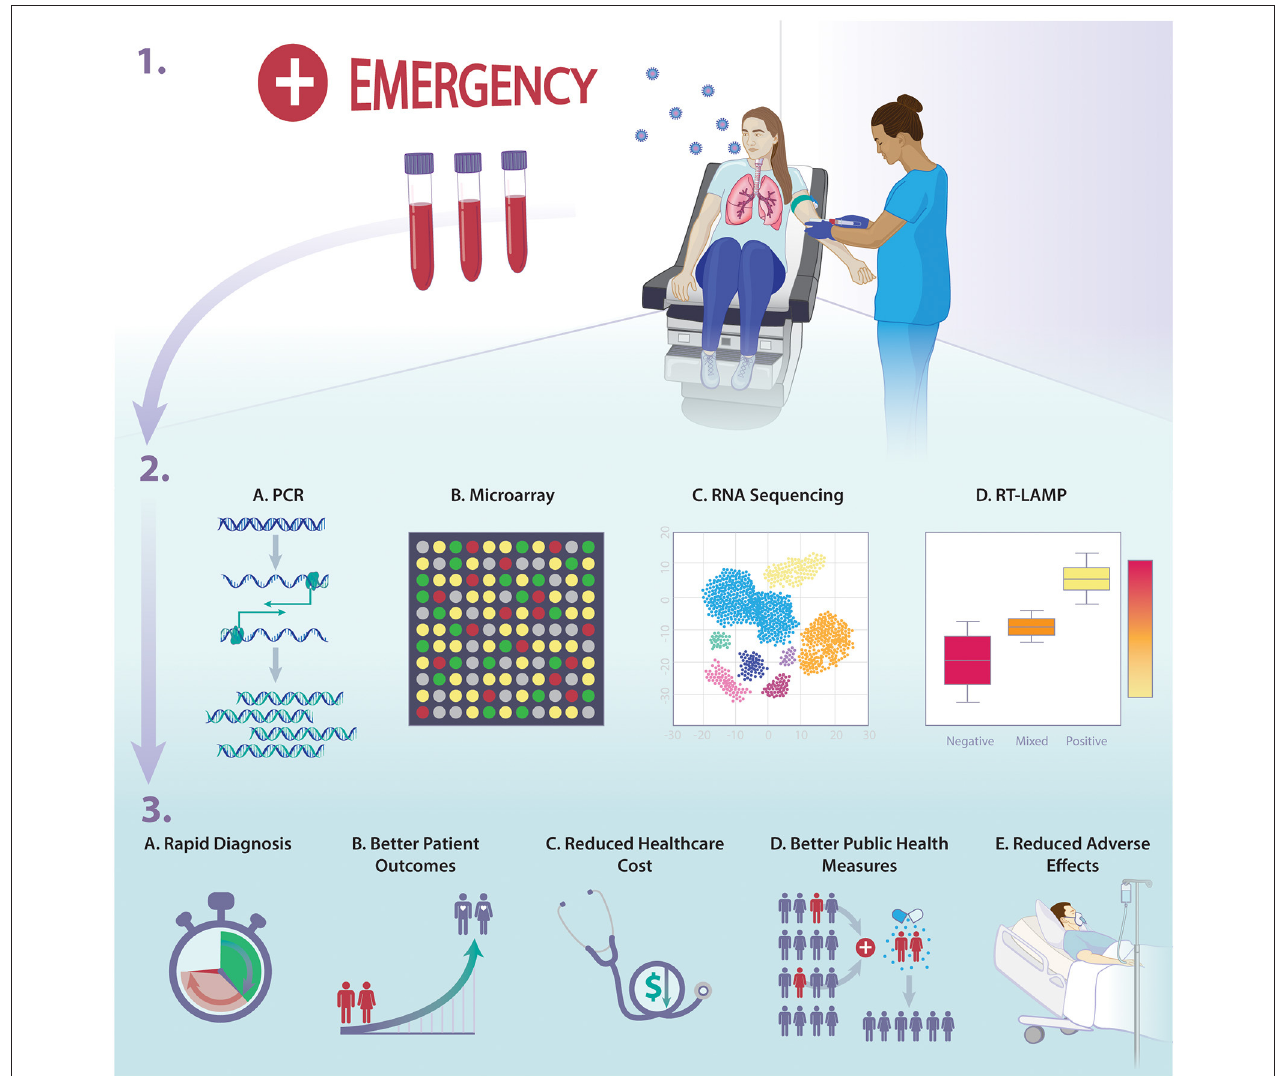
FIGURE 1 | Overview of the implications of host-response diagnostics on infectious diseases management and